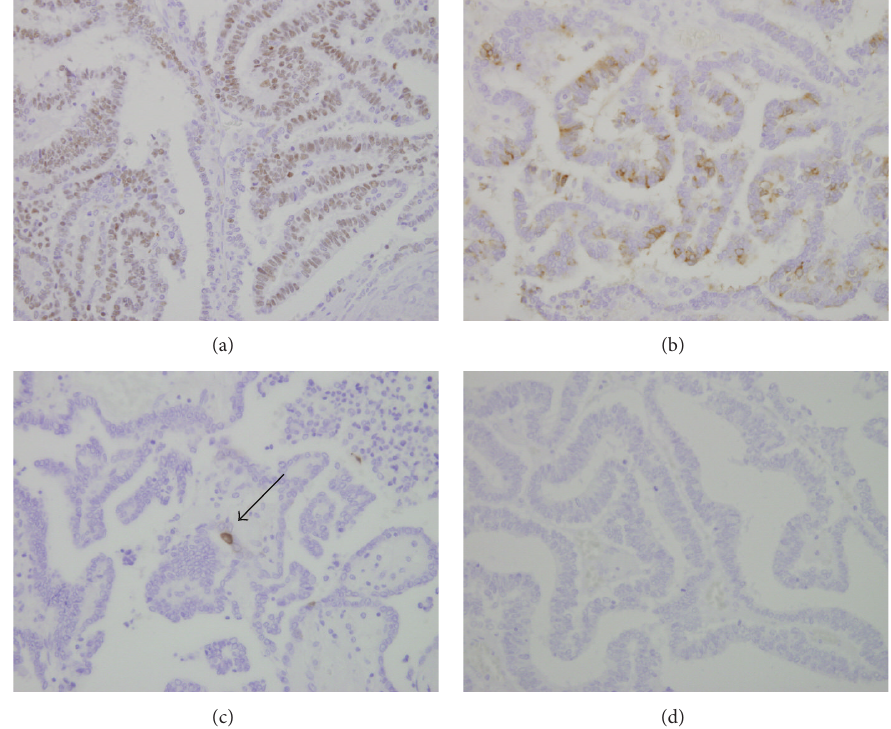
Figure 3: Immunohistochemical findings of the tumor. (a) The tumor cells were positive for WT-1. (b) The tumor cells were positive for CD57. (c) The tumor cells were occasionally positive for CK7 (arrow). (d) AMACR failed to be detected in the tumor cells. which suggests some relationships with papillary RCC